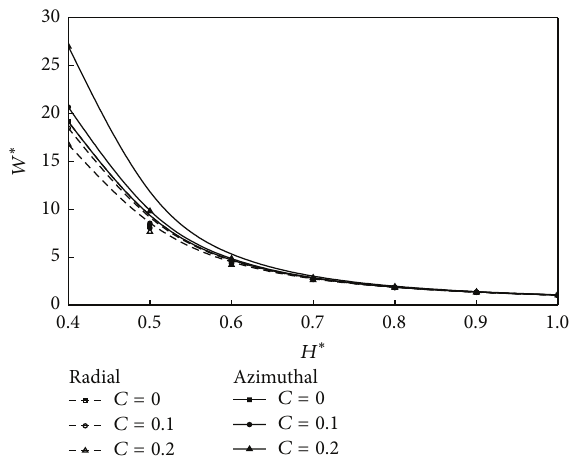
Figure 5: Variation of nondimensional load carrying capacity 𝑊 ∗ with 𝐻 ∗ for different values of 𝐶 with 𝑀 0 = 3 and 𝑙 ∗ = 0.3 .